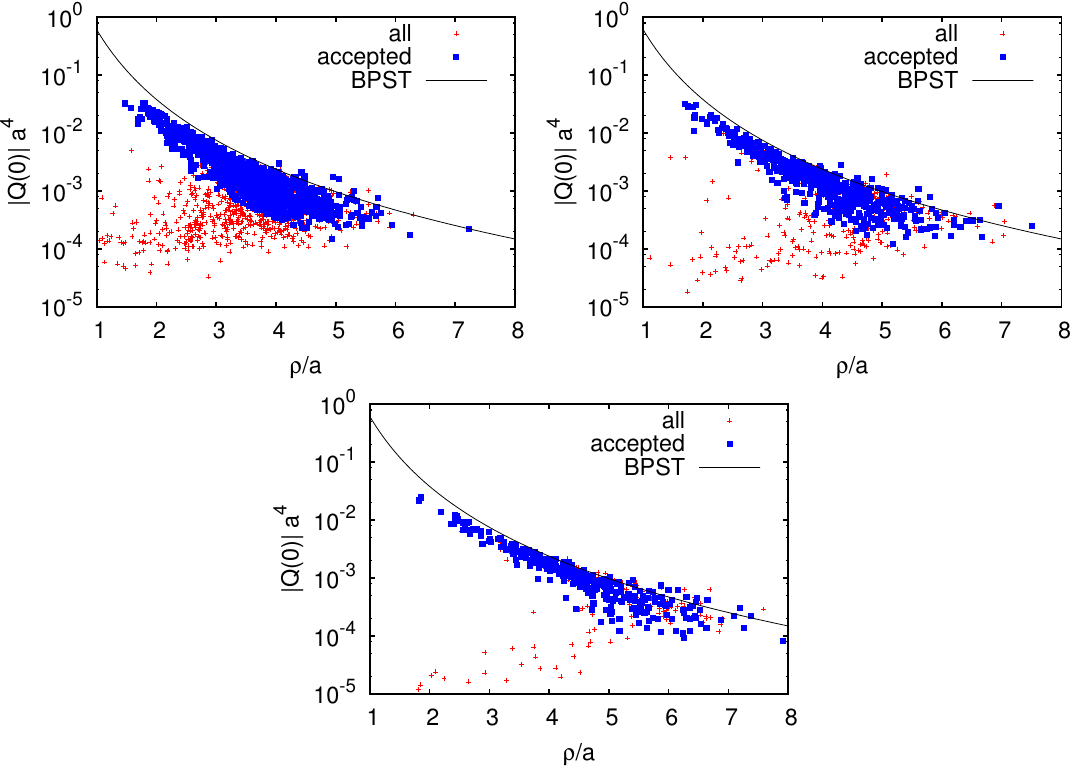
Figure 1 . (Color online) Absolute value of the topological charge density at the extrema (in lattice units) vs. instanton size (cid:26) determined from the (cid:12)t described in the text for a particular gauge (cid:12)eld con(cid:12)guration of (cid:12) = 4 : 2, V = 32 4 after (cid:28) =4 (leftmost upper panel), 8 (rightmost upper) and 15 (lower) Gradient (cid:13)ow times. Those extrema accepted as instantons are represented by blue squares, while the rejected ones are represented by red crosses. The full line represents the relation eq.